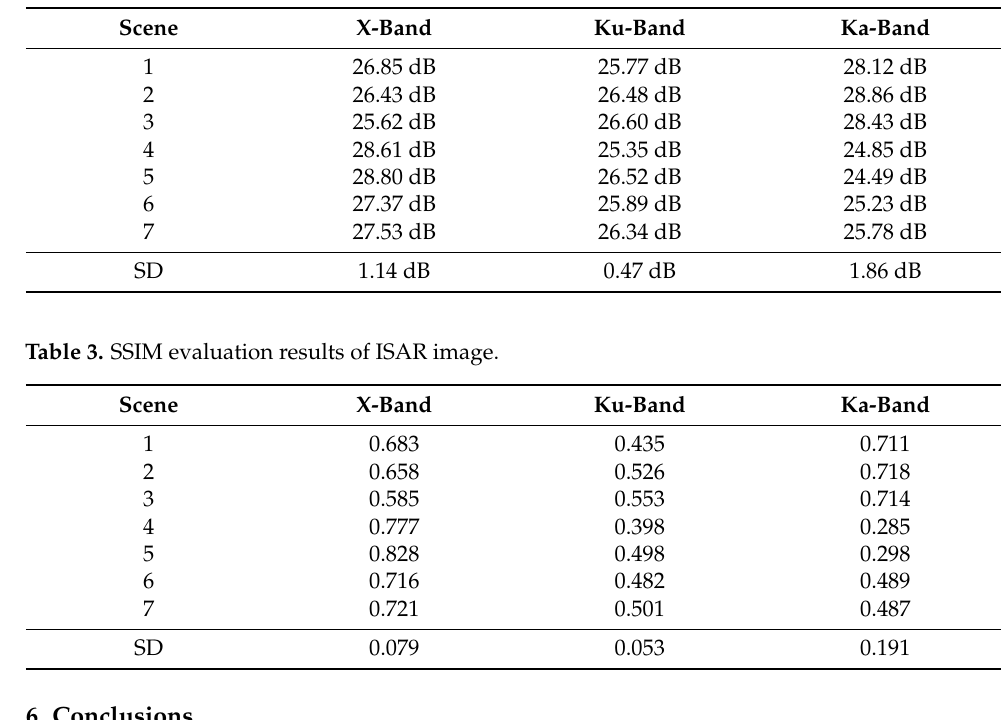
Table 2. PSNR evaluation results of ISAR image.